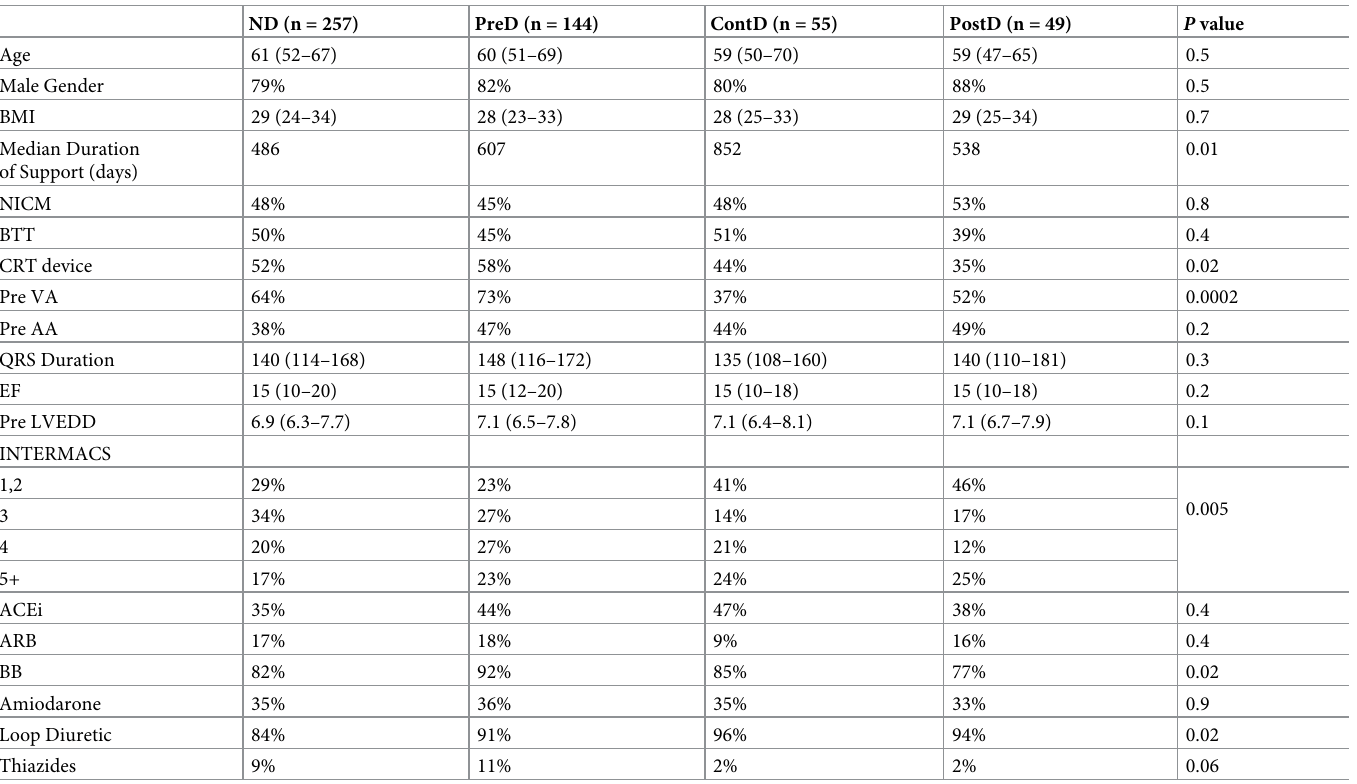
Table 1. Baseline demographics by